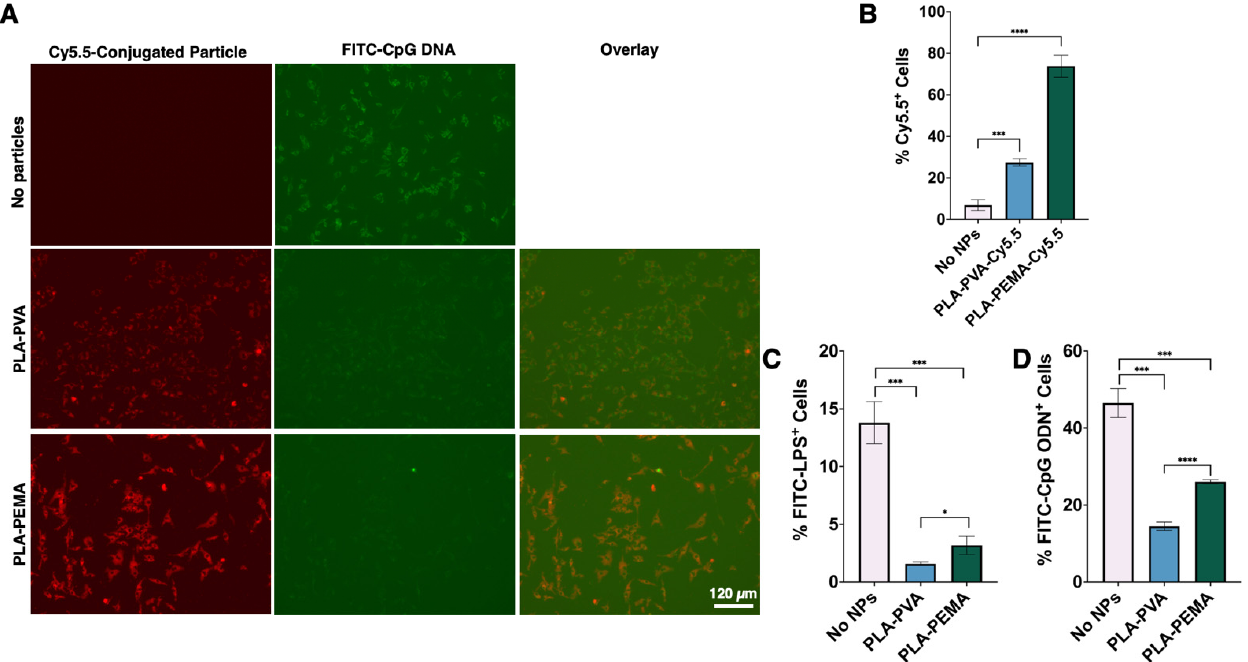
Figure 3. PLA-PVA and PLA-PEMA particle formulations show similar behavior when interacting with TLR agonists and cells with the exception being the increased propensity of PLA-PEMA particle uptake by cells. ( A ) Fluorescence microscopy establishes that PLA-PEMA-Cy5.5 interact to a greater extent with BMM Φ s than PLA-PVA-Cy5.5. ( B ) Quantification with flow cytometry after 1-hr co-incubation at 37 °C and 5% CO 2 confirms cells associate to a greater extent with PLA-PEMA-Cy5.5 particles (30 µg/mL) than PLA-PVA-Cy5.5 particles (30 µg/mL). Both PLA-PVA (300 µg/mL) and PLA-PEMA (300 µg/mL) treatments result in dramatic decreases in BMM Φ cellular uptake of ( C ) FITC-LPS (100 ng/mL) and ( D ) FITC-CpG ODN (100 ng/mL) following 18-hr incubation at 37 °C and 5% CO 2 . Statistical differences between groups were determined by performing a Student’s t -test. Error bars represent SD. * for p ≤ 0.05, *** for p ≤ 0.001, and **** for p ≤ 0.0001.